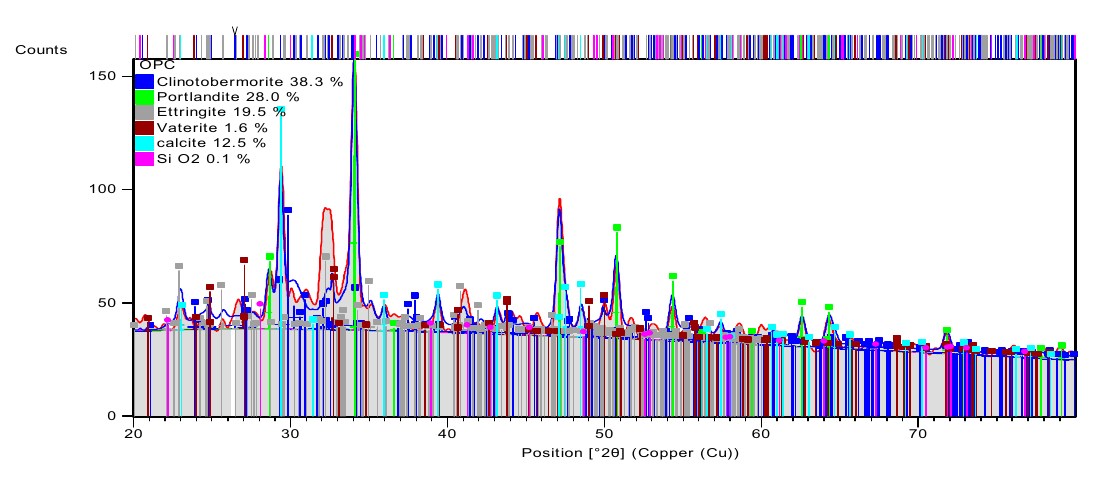
Figure 18. XRD of OPC paste at 7 days of ambient curing. Fourier transform infrared spectroscopy (FTIR) was performed to find the chemical bond present in the low-calcium and high-calcium paste cured at seven days. FTIR spectra of the low calcium (FA and MK) and high calcium (GGBS and OPC) paste are shown in Figure 20. The presence of various chemical bonds in the pastes included H-OH (bending and stretching band), OCO (absorption band), TOT (T: tetrahedral Si or Al), and